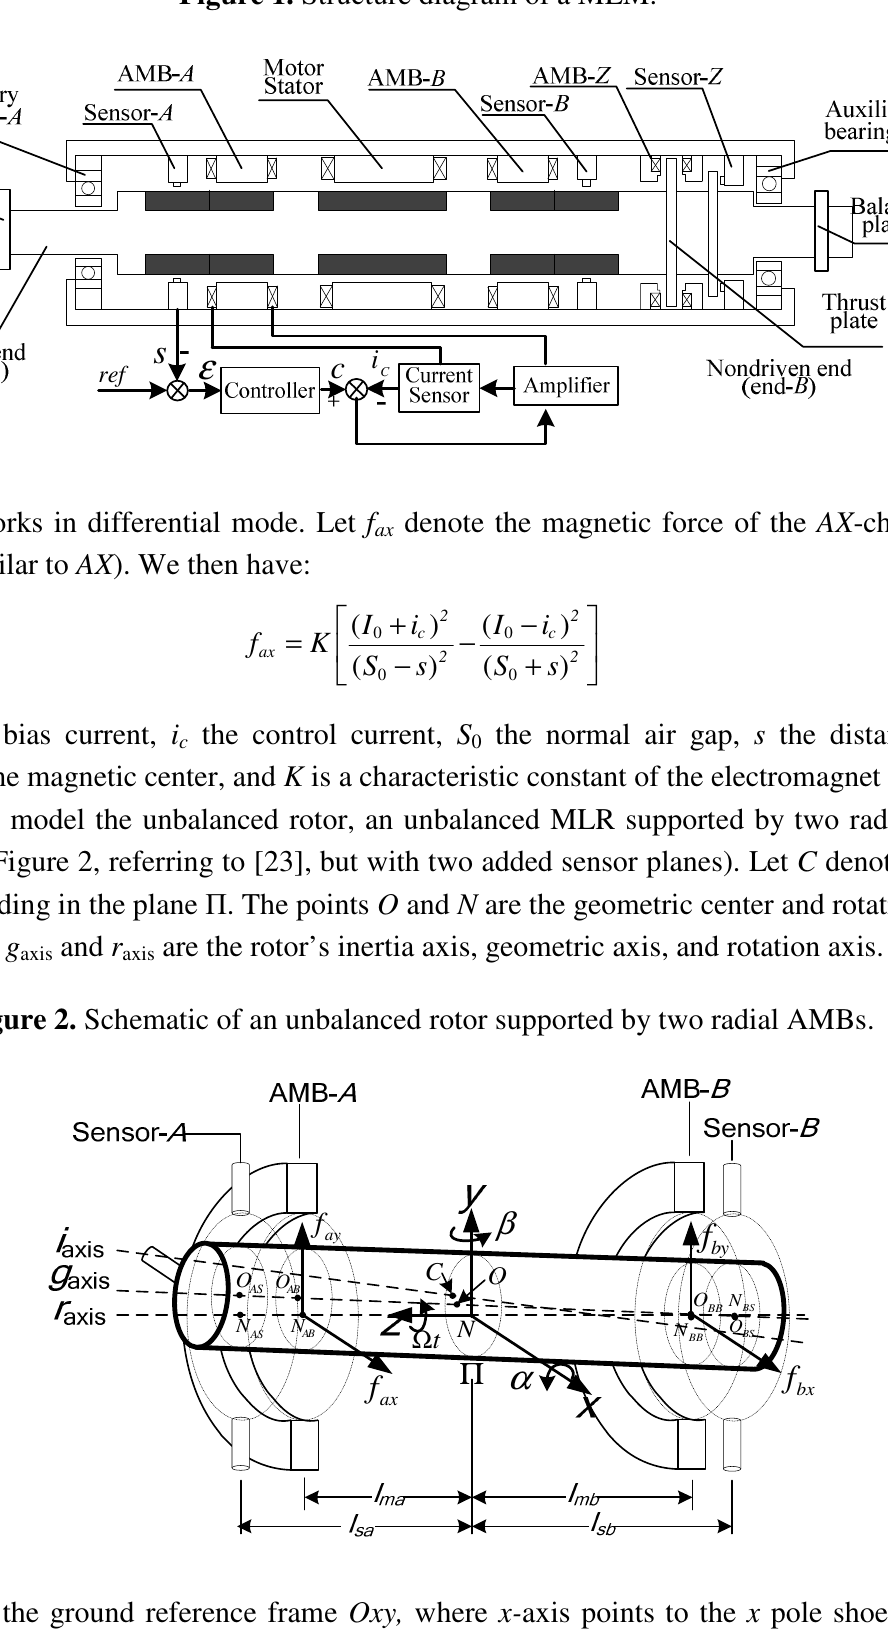
Figure 1. Structure diagram of a MLM.